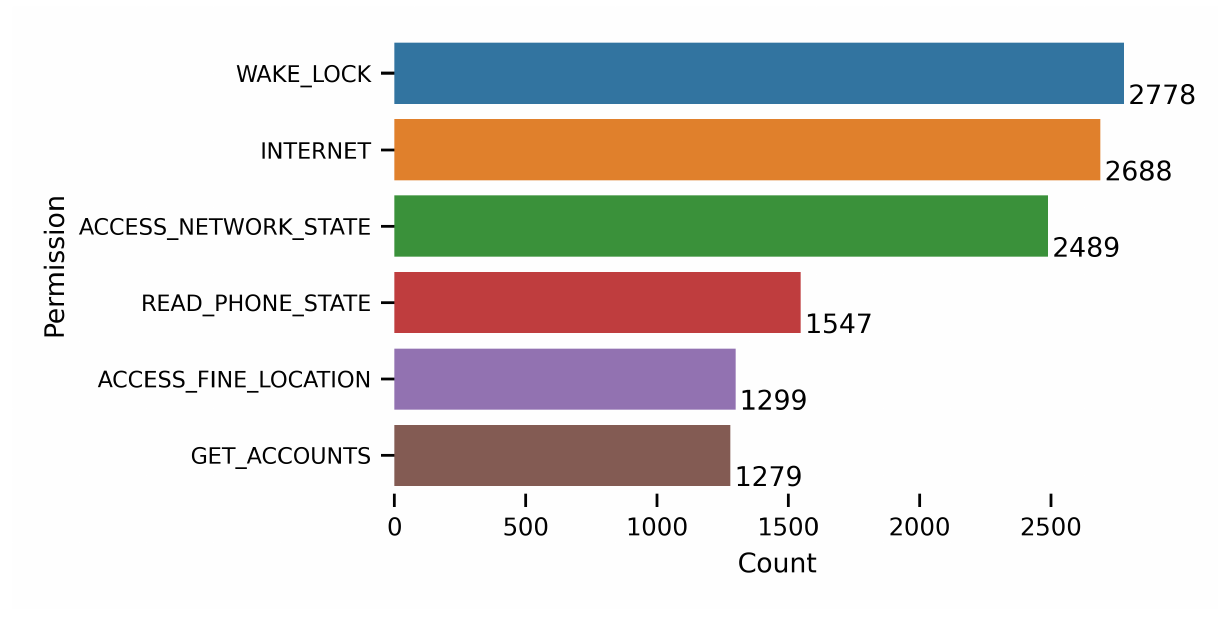
Figure 2. Wake Lock Permissions in Empirical Study